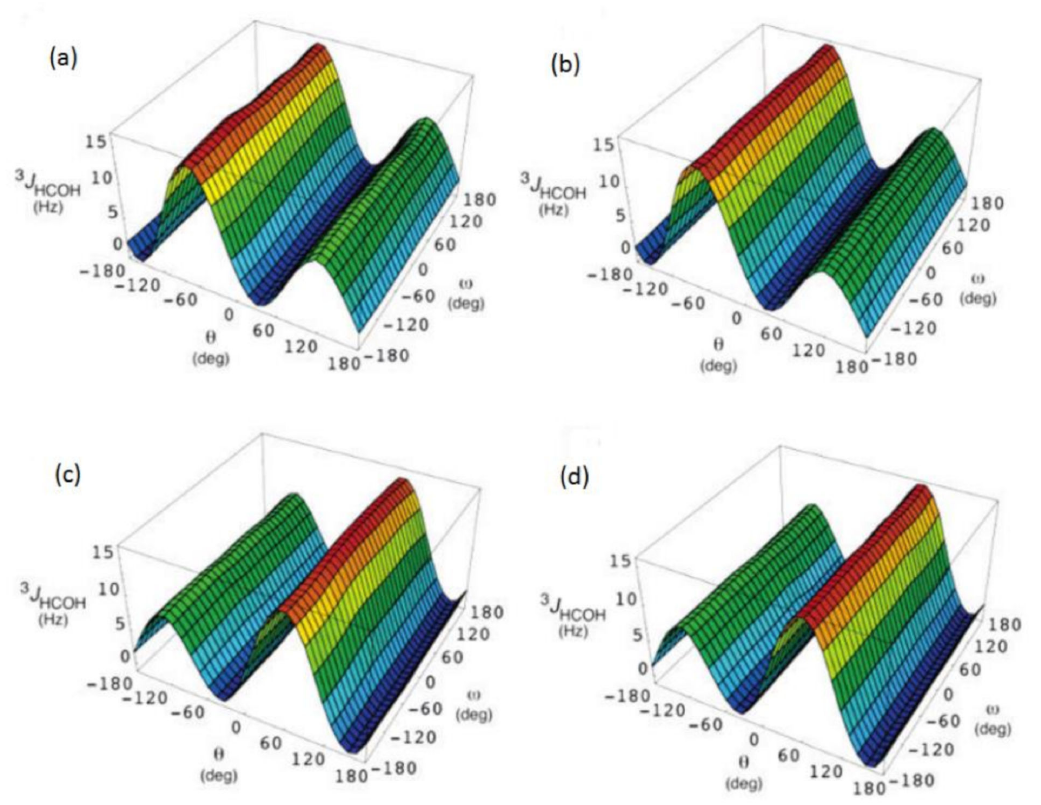
Figure 19. Dependences of calculated 3 J (H-2,O-2H) on the dihedral angles ω and θ in ( a )—compound 15 , ( b )—compound 16 , ( c )—compound 17 , and ( d )—compound 18 . Reproduced from Zhao et al. [124] with the permission of the American Chemical